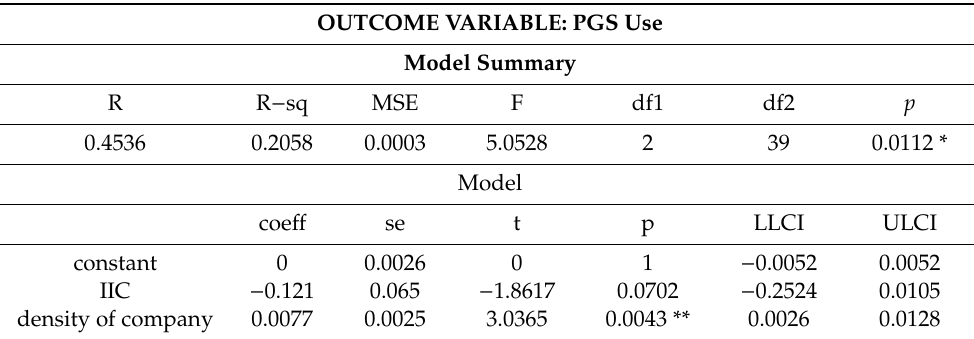
Table 5. Detailed analysis results of Model 2 (mediator: Density of